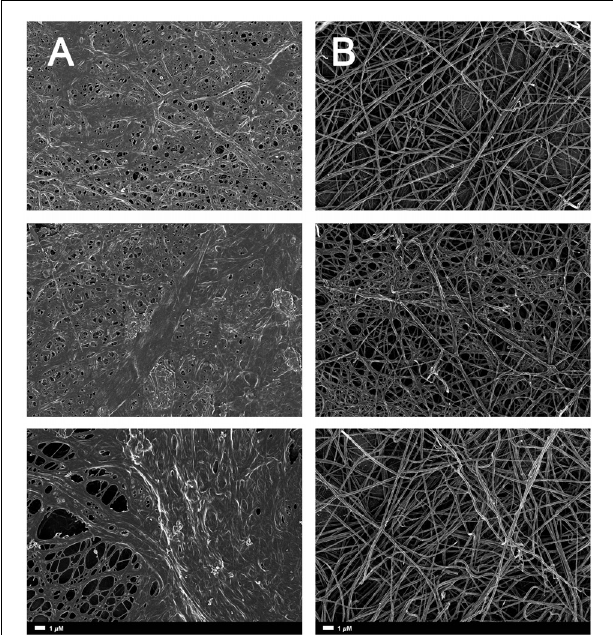
FIGURE 3 | (A) Naïve clot structures from representative Alzheimer-type dementia individuals as seen with SEM. (B) The same samples treated with LBP. The size marker is the same for all panels.